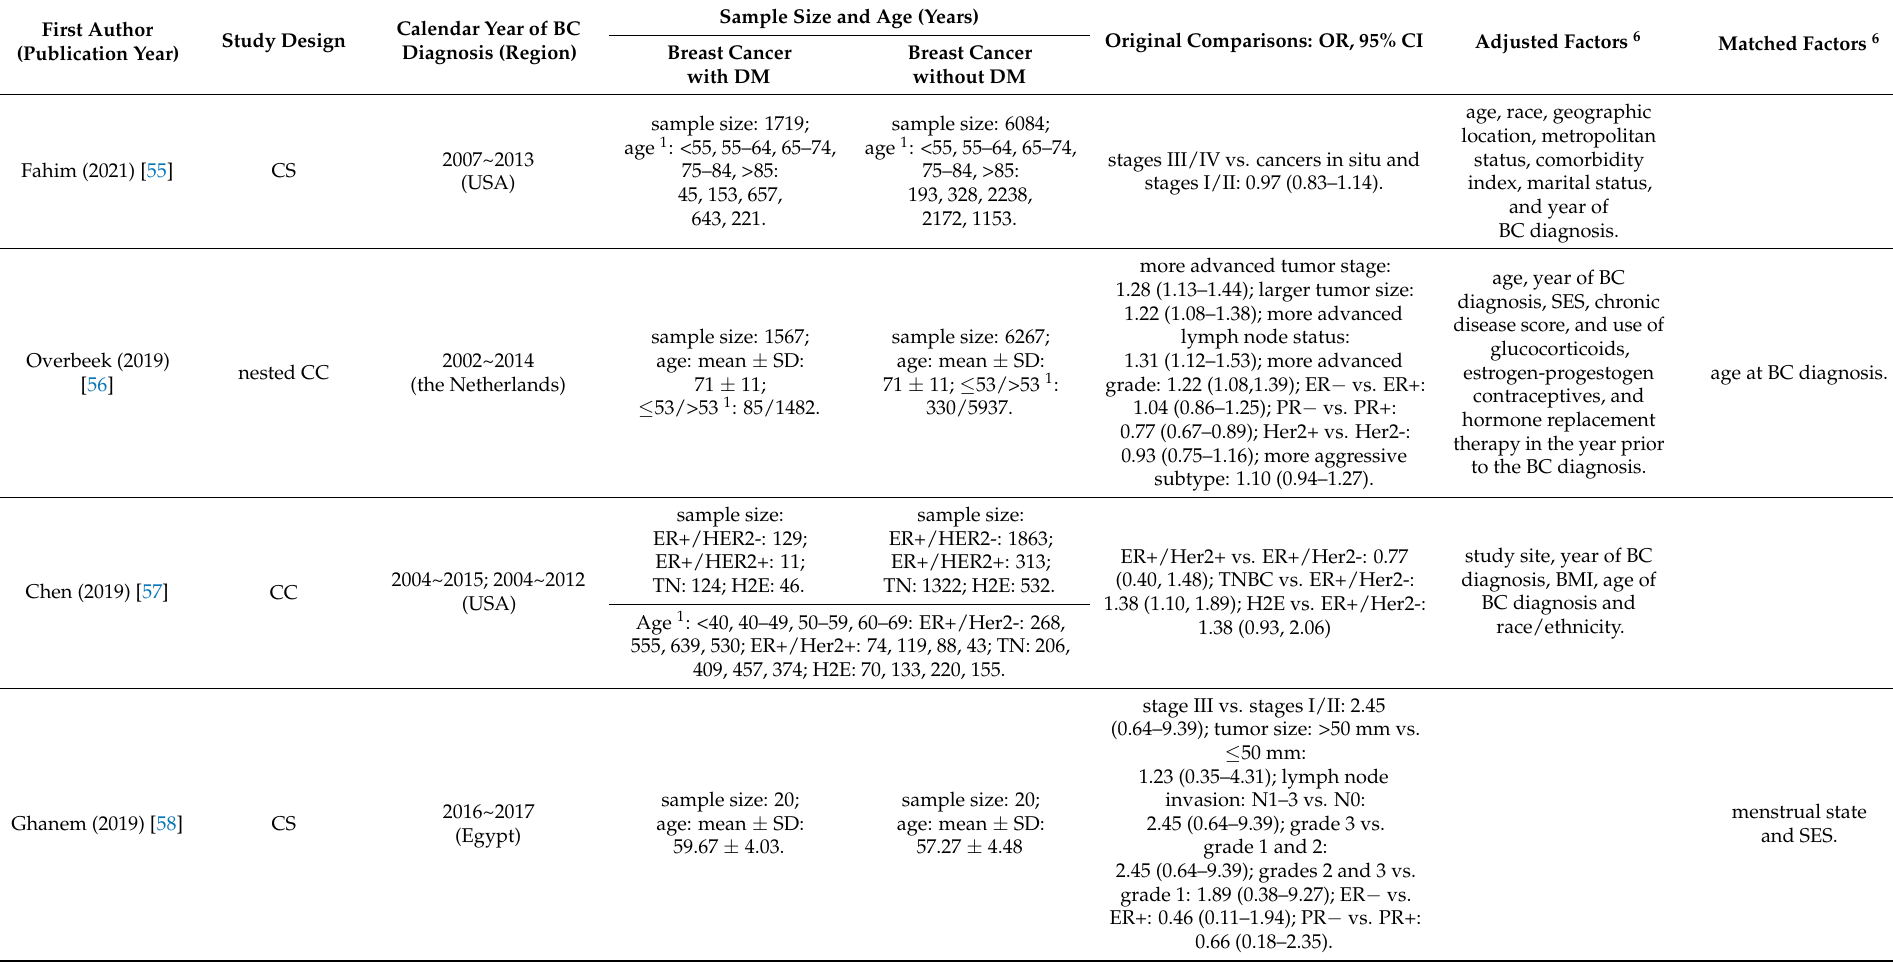
Table 1. Characteristics and results of studies included in the systematic review and